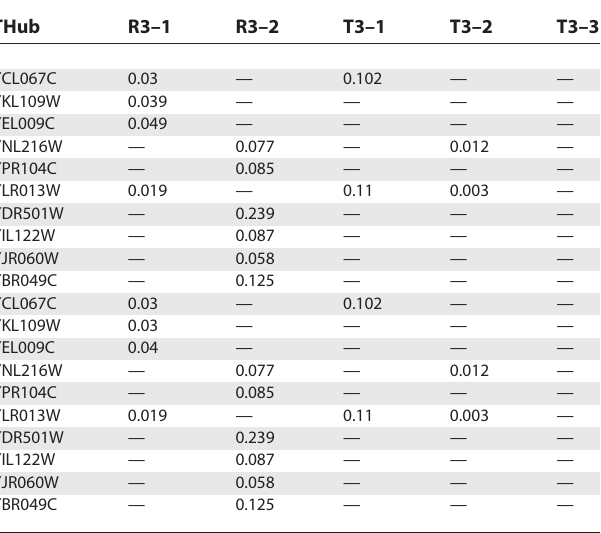
Table 2. The THubs with Preferred 3-Vertices Subgraphs in the Cell Cycle Sub-Network